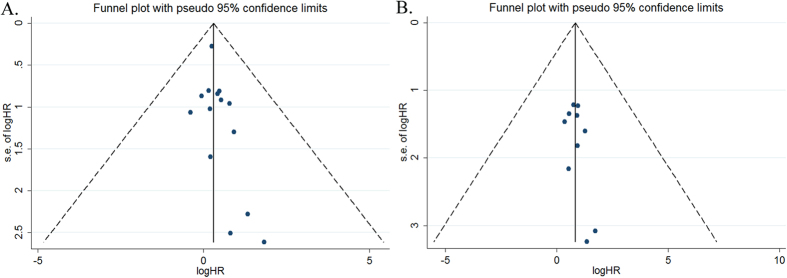
Funnel plot showing publication bias based on the all-cause mortality (A) and cardiovascular mortality (B).